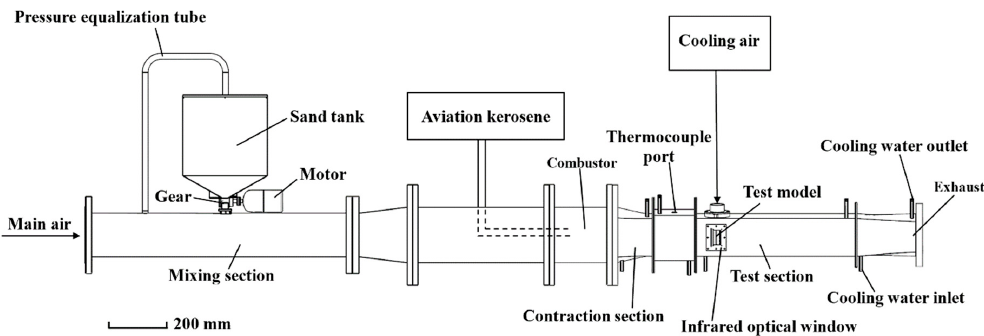
Figure 1. Schematics of the turbine deposition facility.